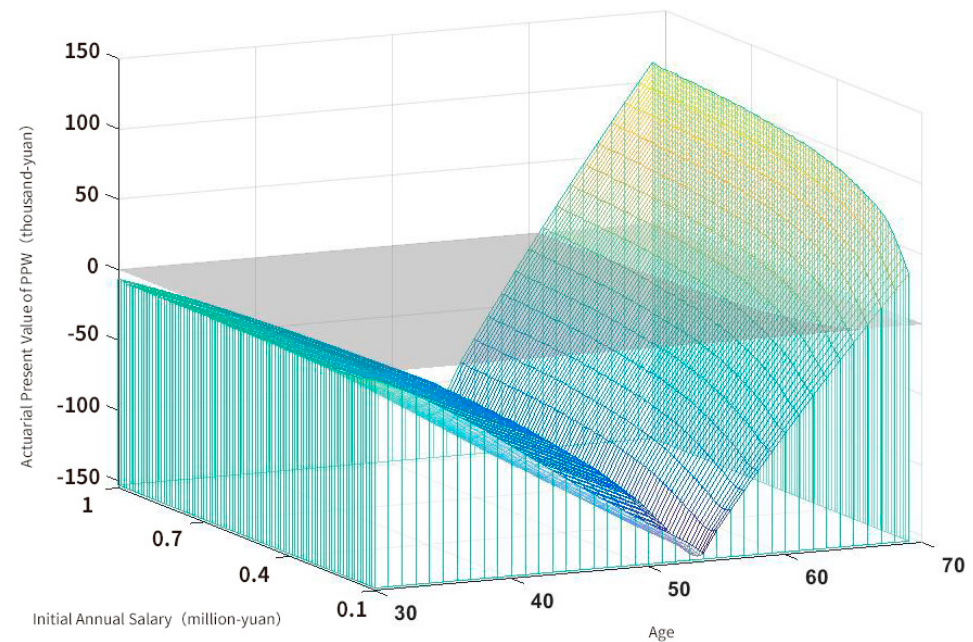
Figure 9. The impact of different initial annual salaries of 30-year-old insured women on the present value of PPW.